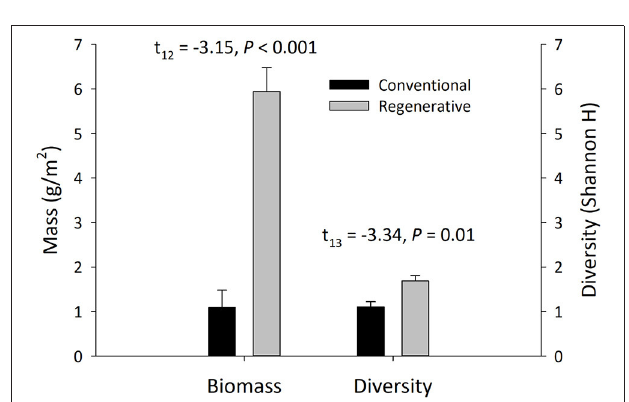
FIGURE 5 | Invertebrate biomass and diversity (Shannon H) of the epigeal invertebrate communities in regenerative and conventional orchards (mean ± SEM, N = 16 orchards, Welch’s two-sample t -test; α = 0.05). Invertebrate communities were collected during the bloom, fruit development, and harvest